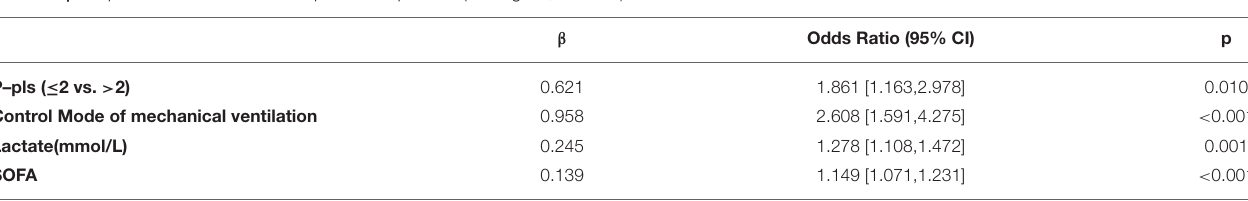
TABLE 3 | Independent risk factors for deep sedation practice (training set, n =